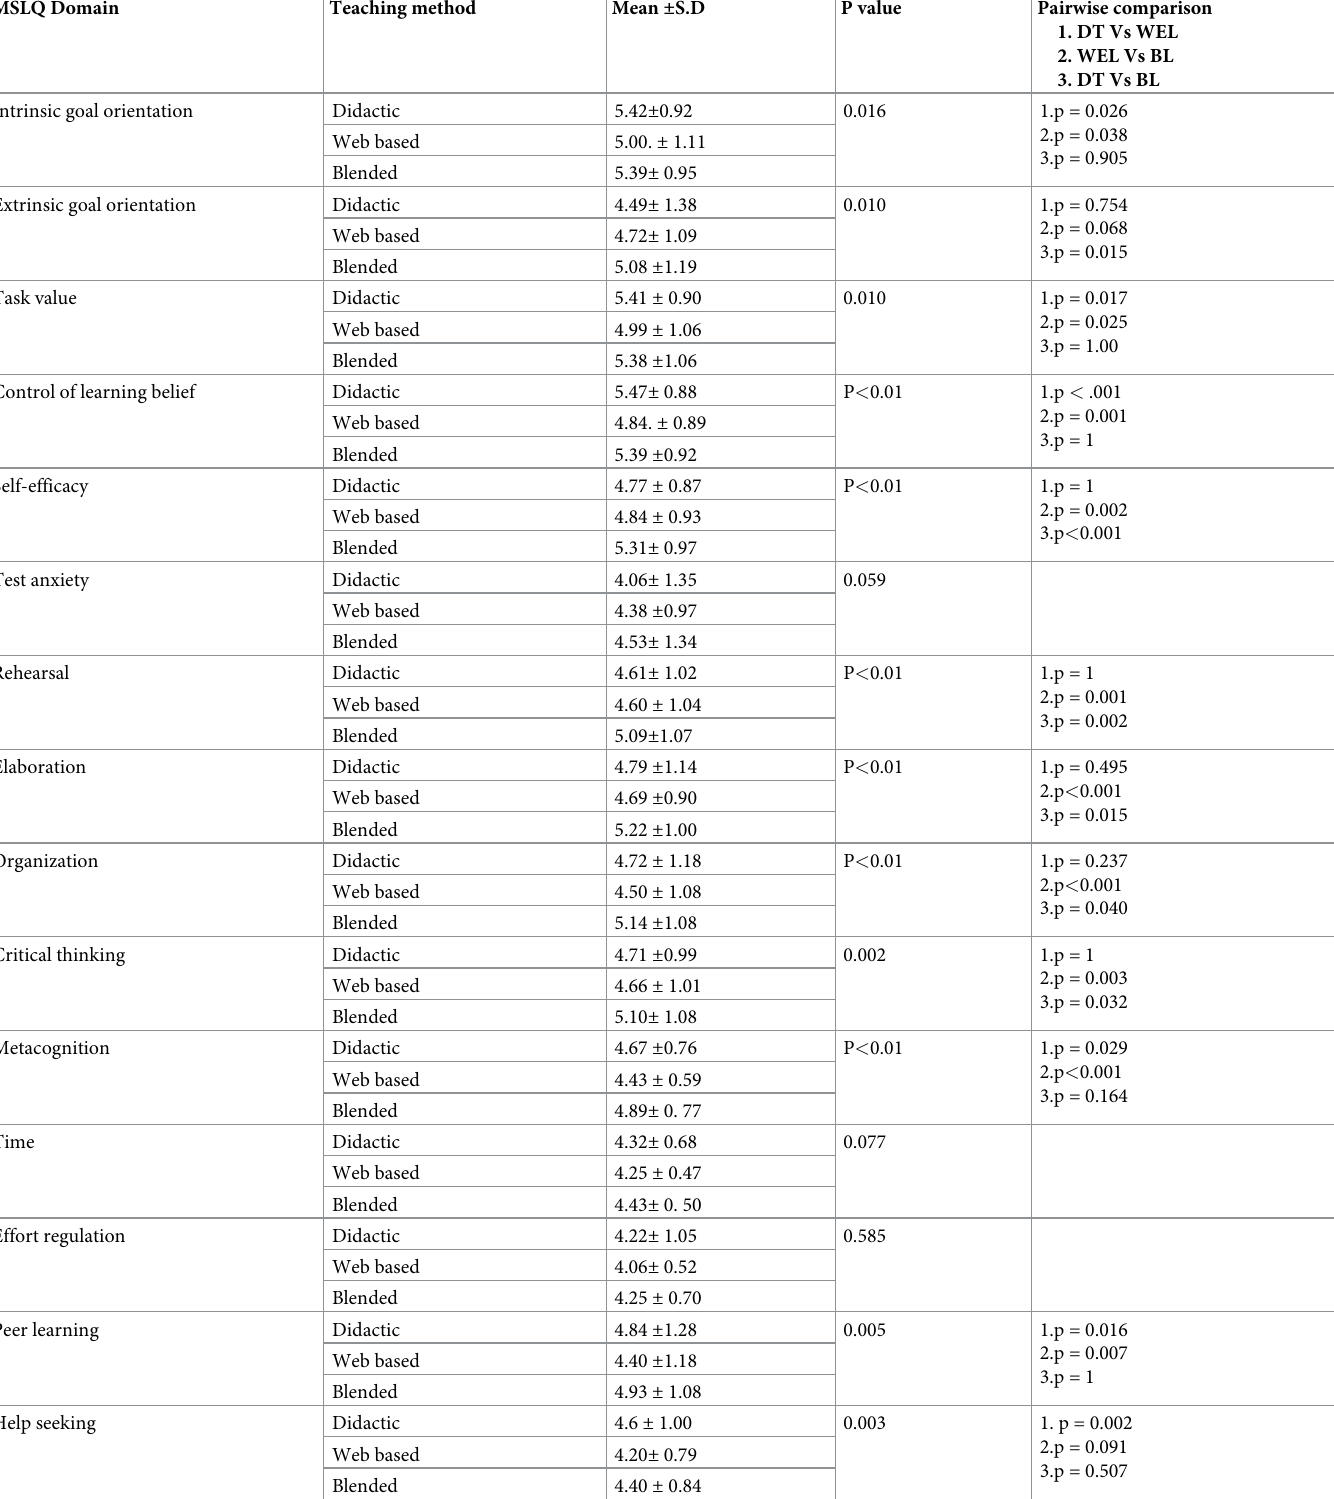
Table 4. Comparison of MSLQ scores between learning